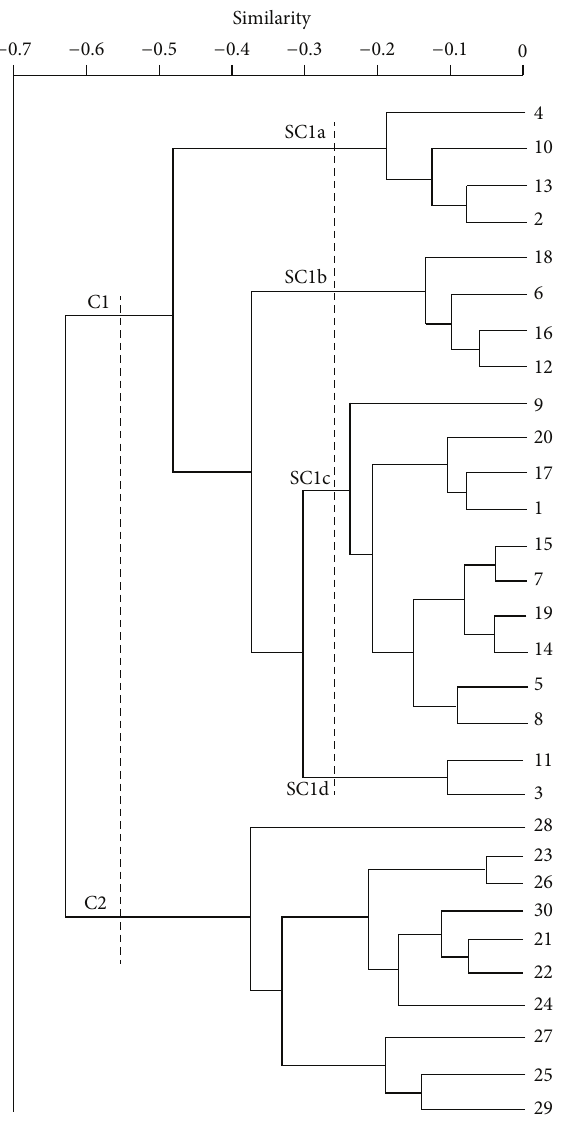
Figure 3: Dendrogram obtained by hierarchical cluster analysis of 30 samples based on FT-IR